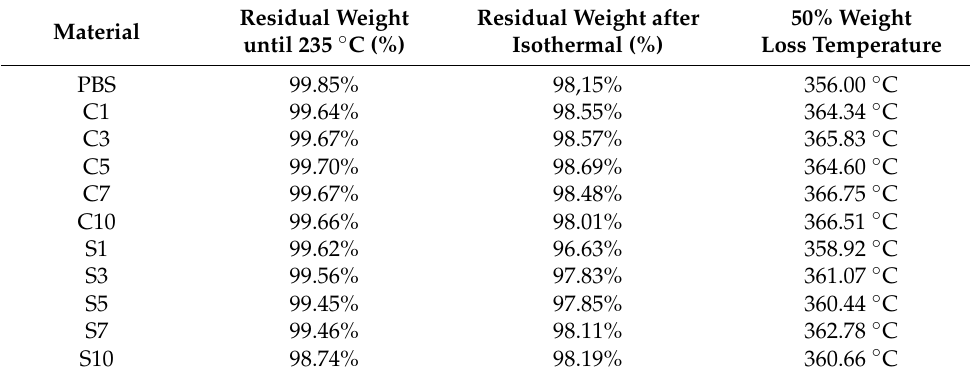
Table 4. Initial degradation temperatures and weight shares at 235 ◦ C for PBS as well as PBS-curcumin and PBS-silver